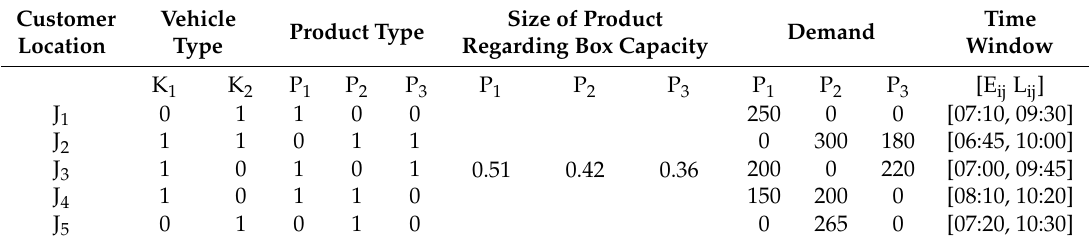
Table 2. An illustrative example of the heterogeneous multi-quality multiple-cold-chain